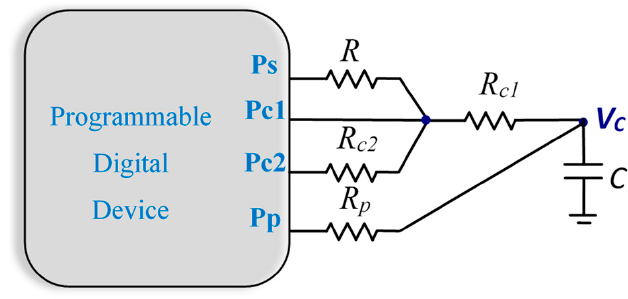
Figure 2. Circuit used in the three-signal auto-calibration method (TSACM).